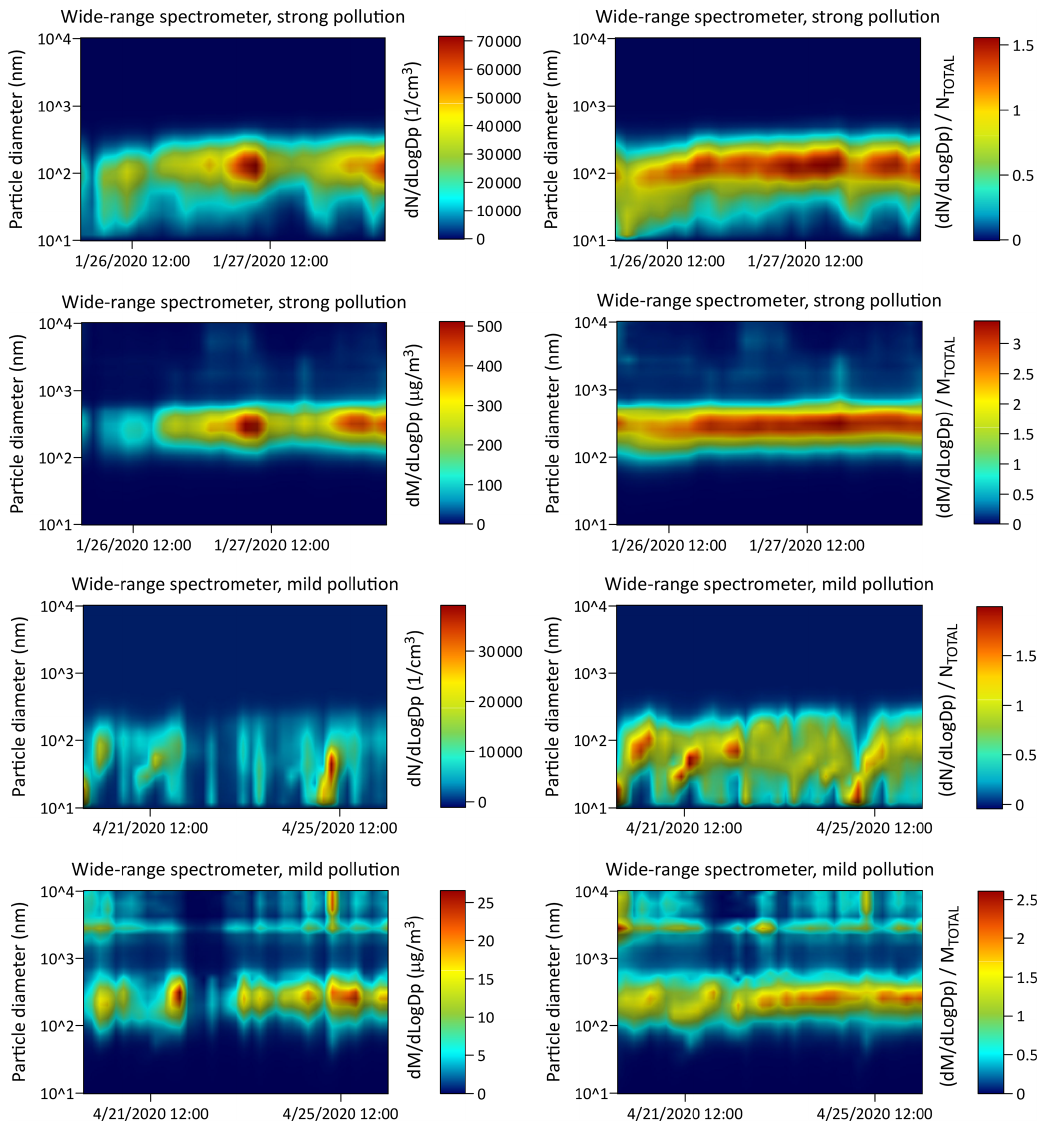
Figure 9. Wide-range spectrometer (SMPS+11D) and hourly average values. Relative density 1.65 was applied to the SMPS to calculate mass of